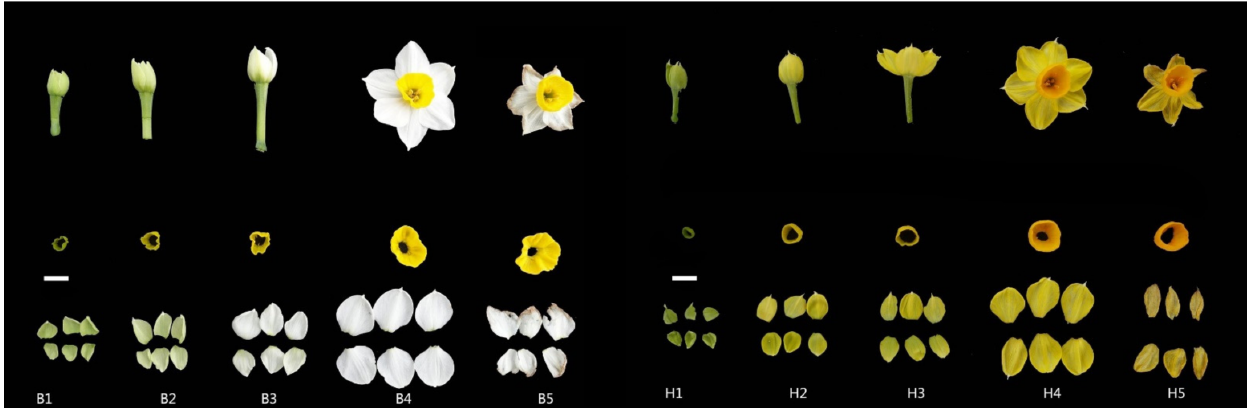
Figure 1. Corolla and tepal tissue of Chinese narcissus. The materials harvested at bud stage, initial flowering stage, full bloom stage, full expansion stage, and decay stage. Among them, the left is ‘Jinzhan Yintai’ ( B1 – B5 ), and the right is the yellow mutant ( H1 – H5 ). Bar = 1